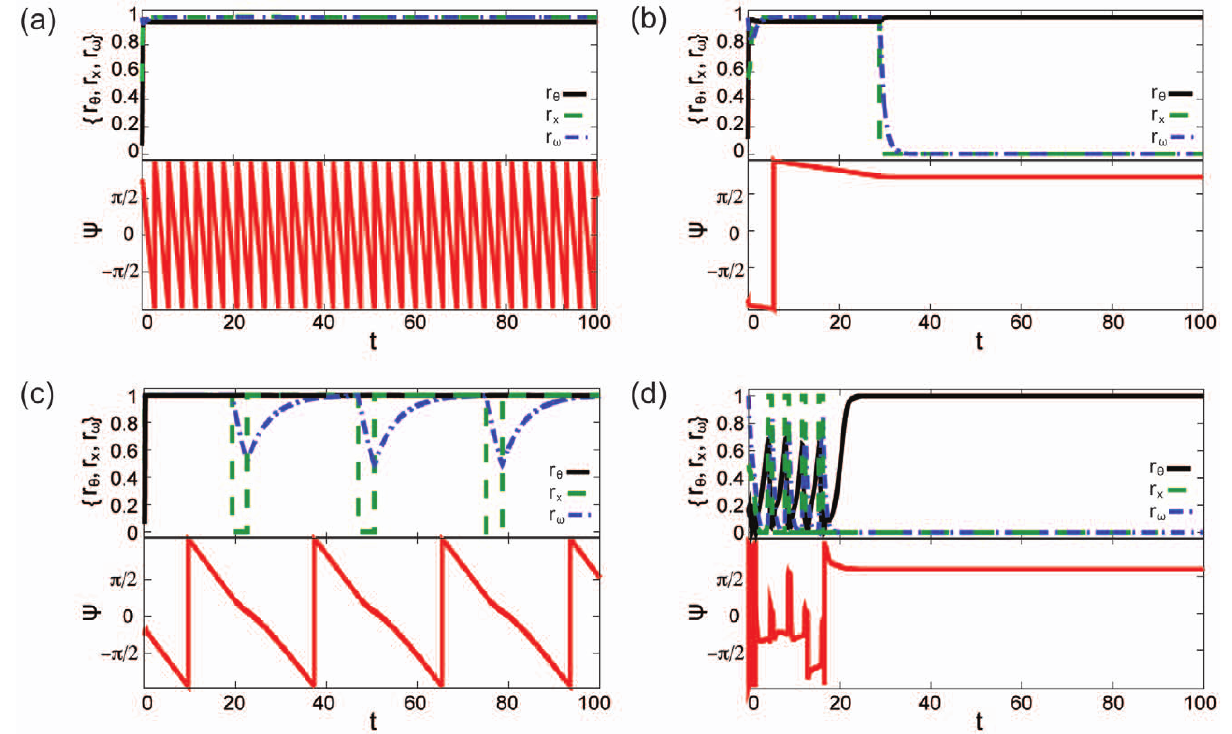
Figure 1. Summary of the qualitative dynamics of the heterogeneous network model of eqs. (8)–(10). In all figures, top-panel shows temporal evolution of the mean field statistics ( r h black, solid; r x green, dashed; and r v blue, dash-dotted) and the bottom-panel shows the evolution of the mean phase y (red, solid). (a) Oscillators synchronize and switches stay ‘‘on’’ ( k x , x ~ 11 , k x , h ~ 1 : 5 , k h , x ~ 1 , k h , h ~ 40 , and s v ~ 10 ), (b) oscillators freeze (as evidenced by unchanging y ) and switches stay ‘‘off’’ ( k x , x ~ 1 , k x , h ~ 1 : 5 , k h , x ~ 1 , k h , h ~ 40 , and s v ~ 10 ), (c) oscillators synchronize and switches oscillate ( k x , x ~ 1 , k x , h ~ 160 , k h , x ~ 0 : 2 , k h , h ~ 42 , and s v ~ 3 ), and (d) transitory oscillations in oscillators and switches ( k x , x ~ 0 : 1 , k x , h ~ 1 : 4 , k h , x ~ 2 , k h , h ~ 1 : 8 , and s v ~ 10 ).